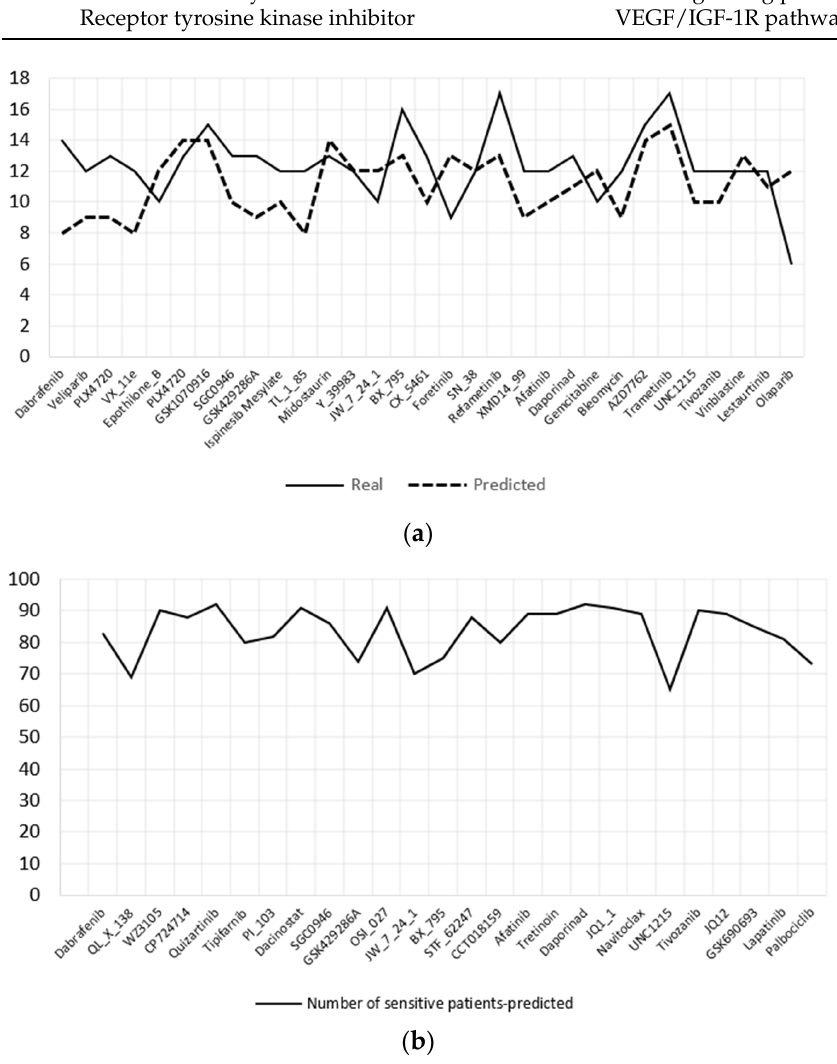
Figure 5. Effective drugs identified by the model for BLBC subtype. ( a ) Top 31 drugs for BLBC cell lines both predicted and real sensitive cell lines are shown. ( b ) Predicted 26 effective drugs for BLBC